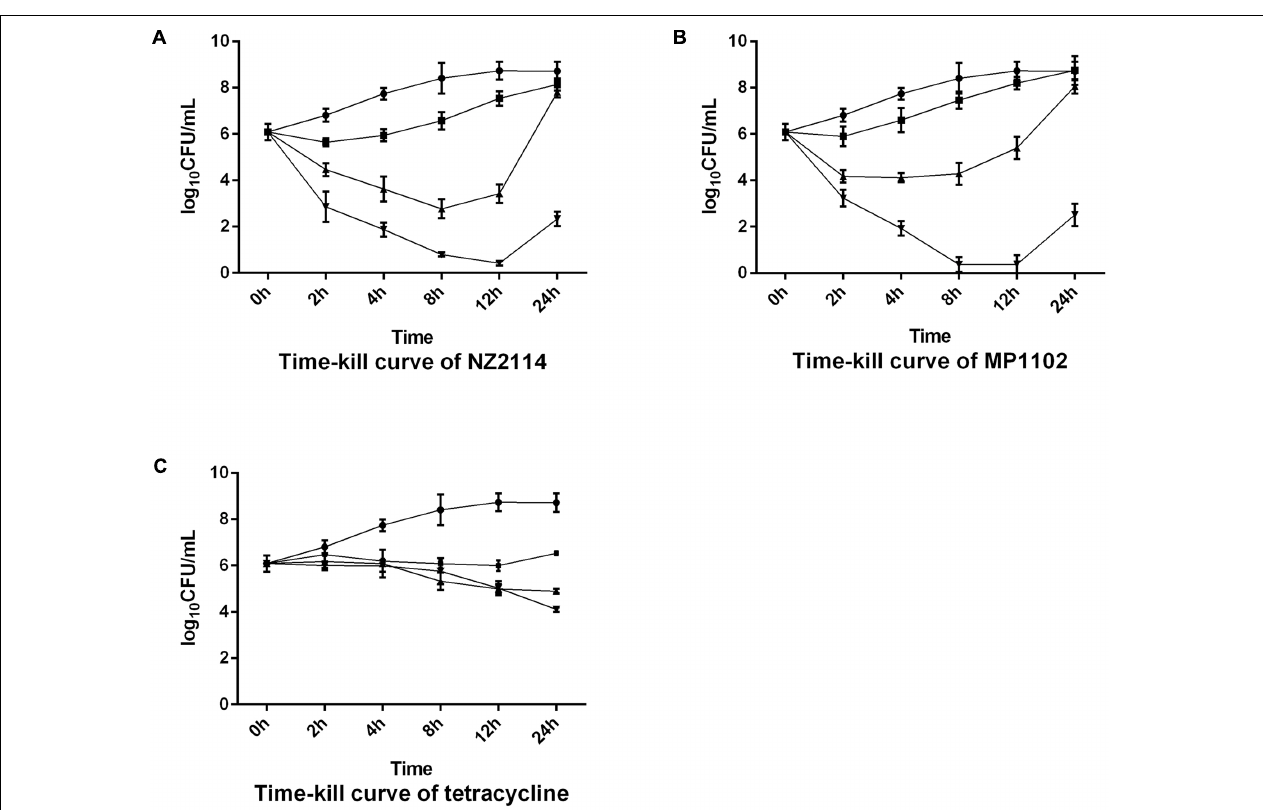
FIGURE 1 | Efficacy of antimicrobials ( A : NZ2114; B : MP1102; C : tetracycline) against Staphylococcus aureus E48 in the culture medium. Different concentrations were used: 0 × (circles), 0.5 × (squares), 1 × (triangles), and 5 × MIC (inverted triangles). Samples were collected at 0, 2, 4, 8, 12, and 24 h post-exposure and colony counts were determined. Each value represents the mean ±